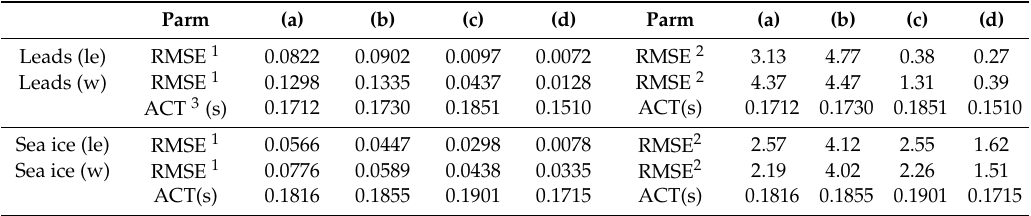
Table 2. Performance of di ff erent segmentation strategies for waveform fitting (Parm: parameters for comparison; le: leading edge; w: whole waveform). The used CS-2 data were collected in March 2014. Further explanations are given in the text. The RMSE in terms of waveform power and range bin are separately shown here.